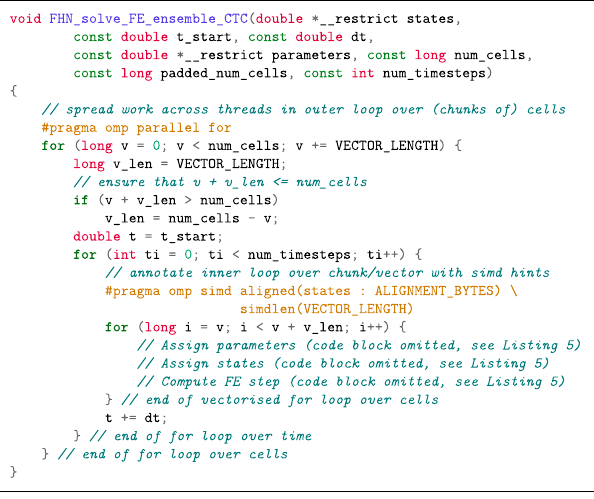
Listing 7: Cell – Time – Cell loop structure in FE solution of the FitzHugh-Nagumo model (ensemble